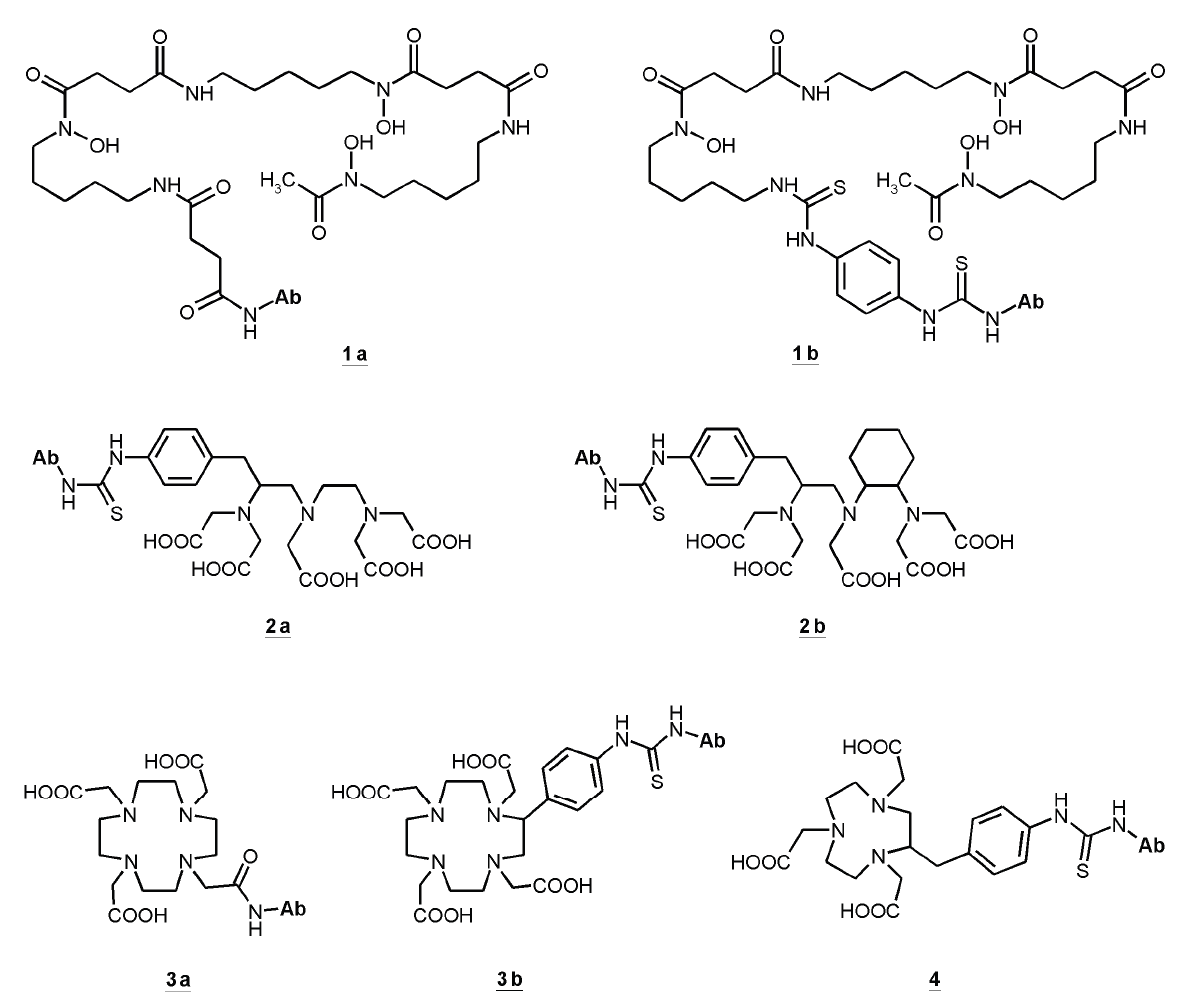
Figure 5. Bifunctional chelators (BFC) used in cetuximab conjugates: succinylated desferoxamine ( N -sucDf, 1a ), desferoxamine-p-SCN (Df–Bz–NCS, 1b ), p-SCN-Bn-DTPA ( 2a ), CHX-A''-DTPA ( 2b ), DOTA-NHS-ester ( 3a ), p-SCN-Bn-DOTA ( 3b ), p-SCN-Bn- NOTA ( 4 ). Data from